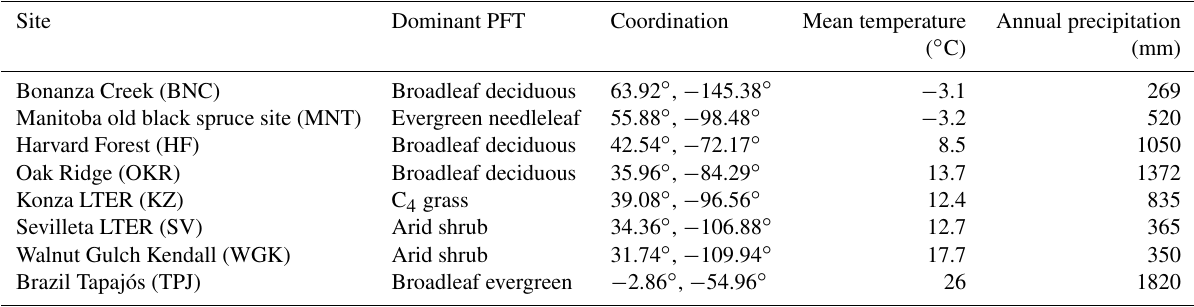
Table 2. Sites for simulated ecosystem development illustration. Site Dominant PFT Coordination Mean